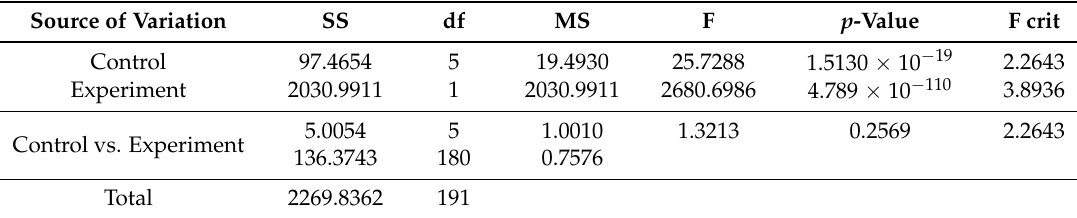
Table 3. Two way ANOVA with replication analysis of P-score.